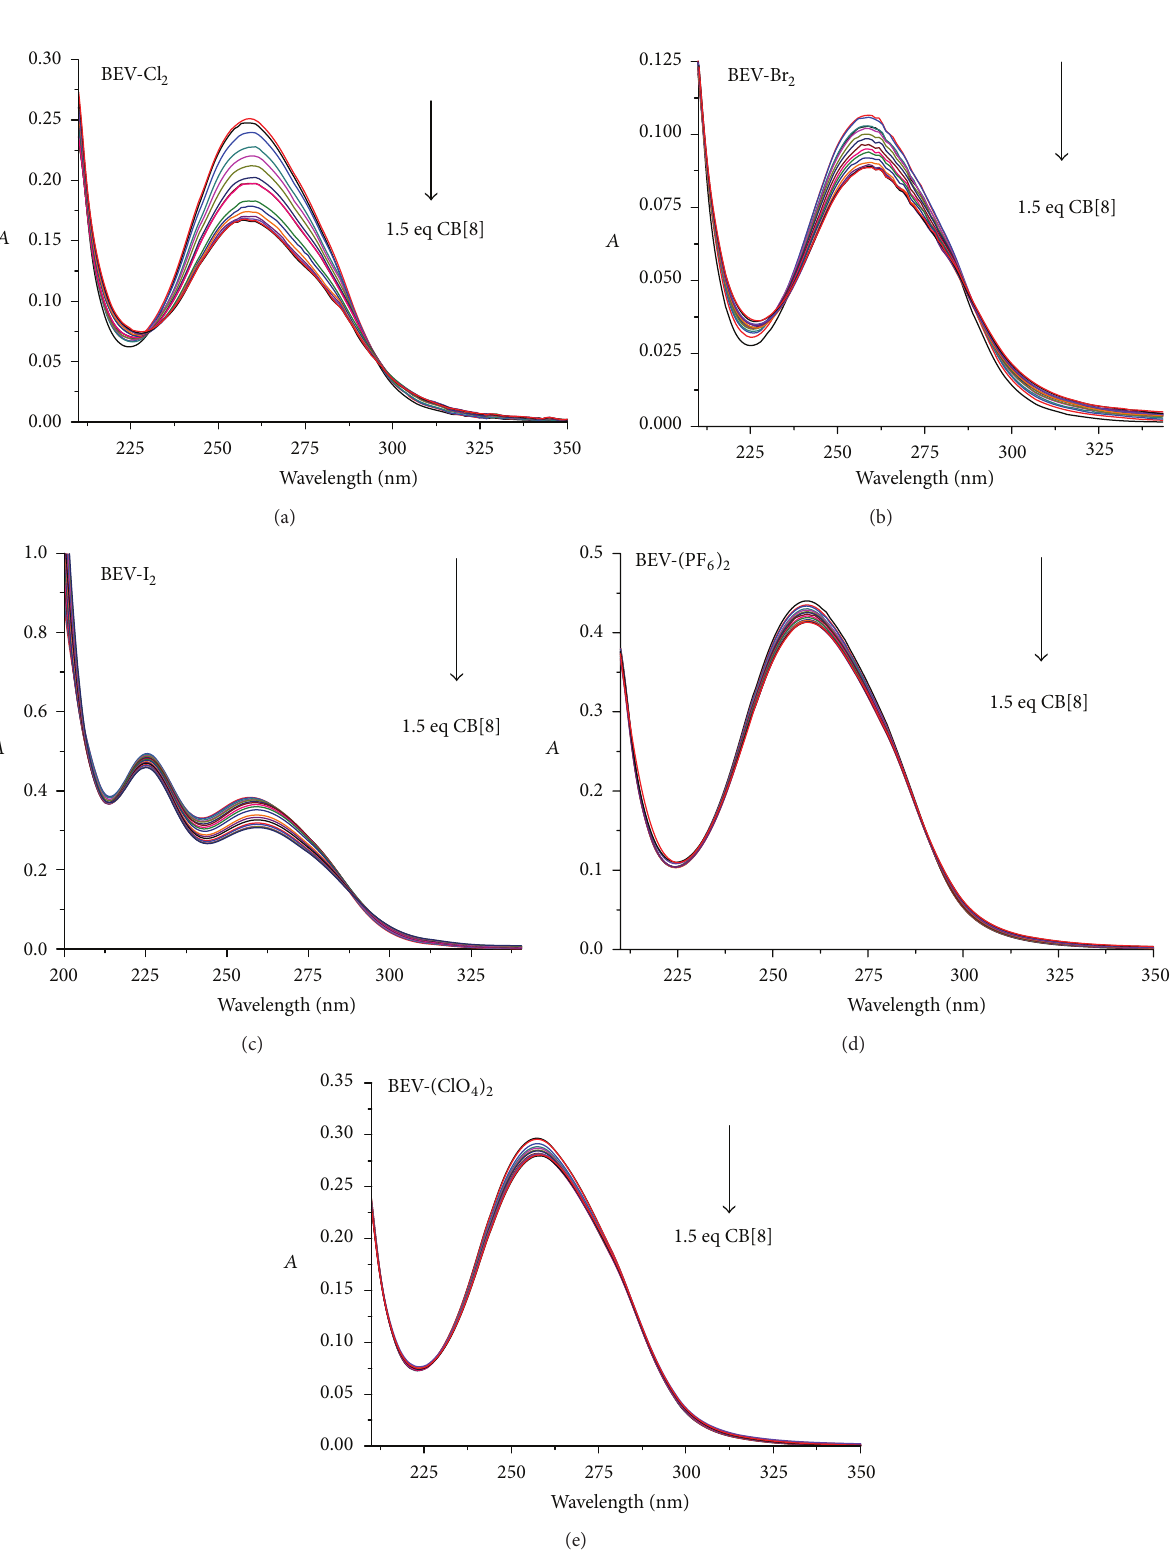
Figure 4: The absorption spectra of BEV-X 2 ( 1 × 10 −5 M) with the addition of different equivalents of CB [8] , (a) BEV-Cl 2 , (b) BEV-Br 2 , (c) BEV-I 2 , (d) BEV-(PF 6 ) 2 , and (e) BEV-(ClO 4 ) 2 , respectively. The concentrations of CB [8] added are 0.05, 0.075, 0.1, 0.125, 0.15, 0.175, 0.2, 0.225, 0.25, 0.275, 0.5, 0.525, 0.75, 1.0, 1.25, and 1.5 equivalents, respectively. The arrows indicate how the absorption bands respond to the increases of the CB [8]